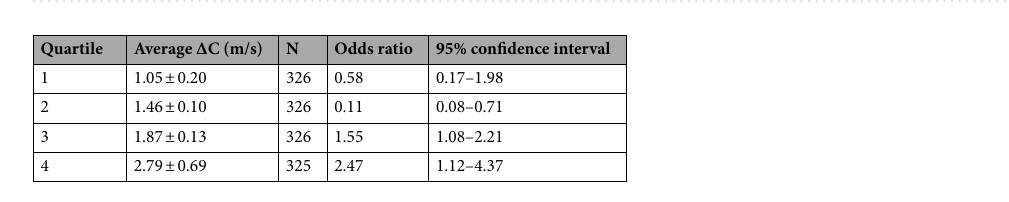
Table 2. Logistic regression model for the occurrence of MetS associated with the carotid ΔC.